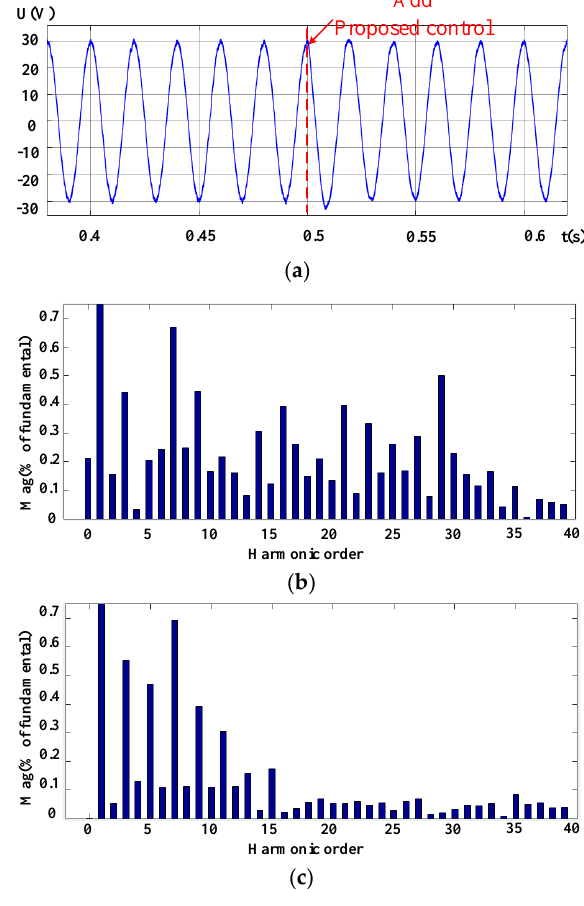
Figure 20. Grid current and its THD analysis. ( a ) Grid current; ( b ) before t =0.5 s (fundamental component = 29.59 A, THD = 2.15%); ( c ) before t = 0.5 s (fundamental component = 29.64 A, THD = 2.01%).